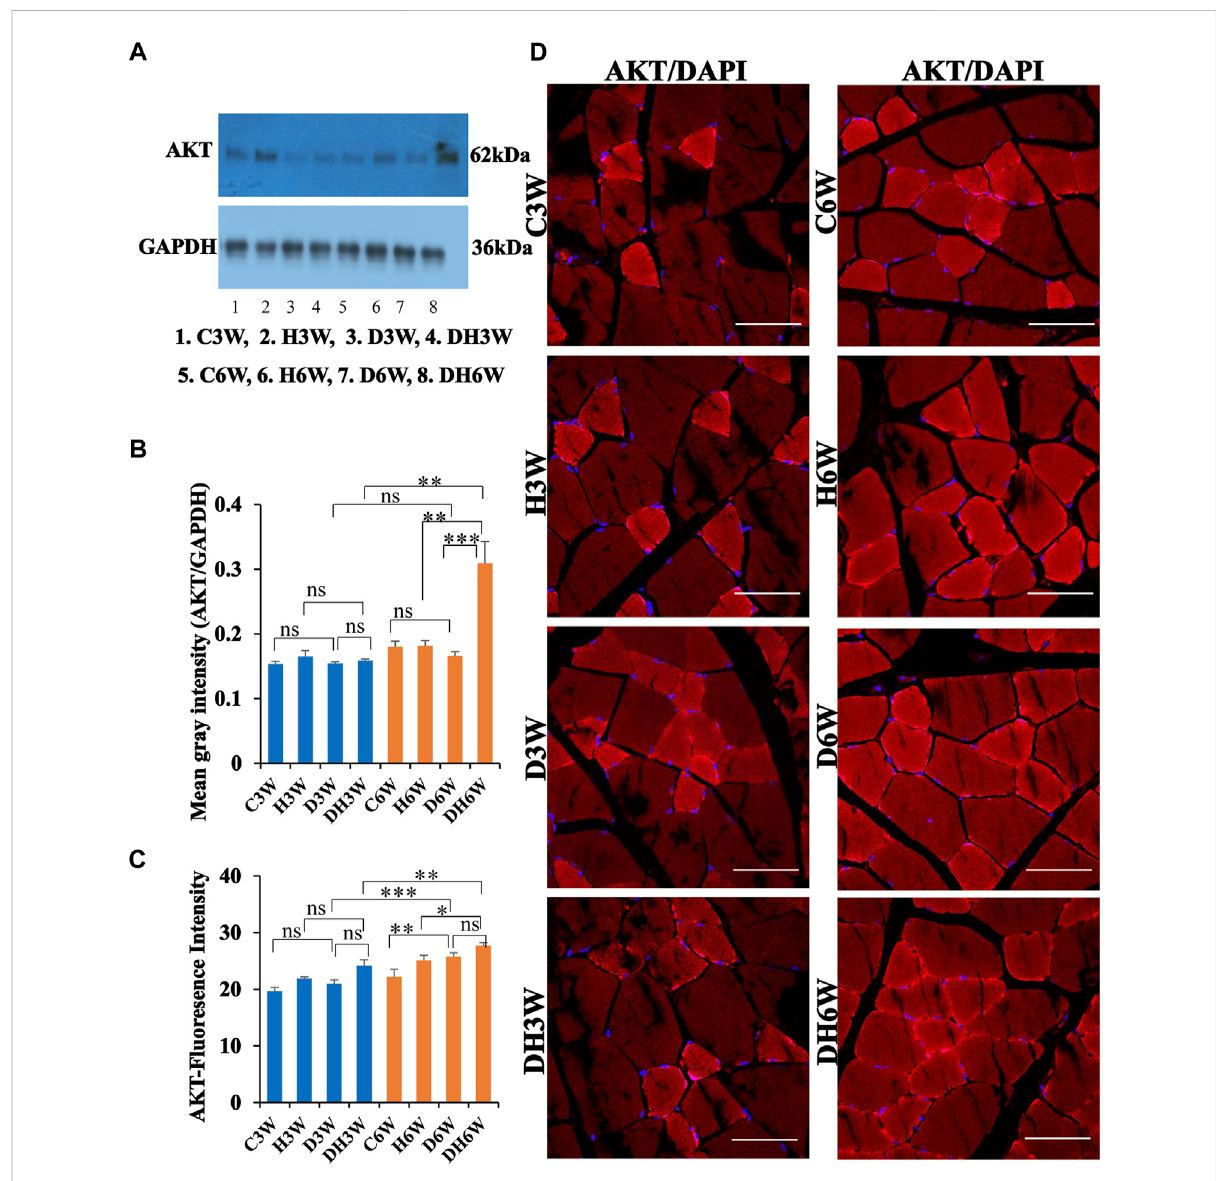
FIGURE 10 (A,B) Immunoblots probed with anti-AKT antibody (A) and mean gray intensity of immunoblots. There were no signi fi cant differences in the expression of AKT (mean gray intensity) between groups in short-term experiment. However, it was increased signi fi cantly in DH6W compared to H6Wand signi fi cantly higher thanD6W.Therewasasigni fi cantincrease inAKT expressionfromshort term(DH3W) to long term(DH6W). (C,D) -AKT immuno fl uorescence intensity (C) and representative cross-section of muscle fi bers stained for anti-AKT immuno fl uorescence in short-term (left panel) and long-term (right panel) experiments (D) . Immuno fl uorescence data showed signi fi cantly increased fl uorescence intensity of AKT in D6W and DH6W compared to C6W and H6W respectively. There was a signi fi cant increase in AKT immuno fl uorescence from short-term (D3W and DH3W) to long-term (D6W and DH6W). Note large number of muscle fi bers showing immuno fl uorescence in D3W, DH3W, D6W, and DH6W (*, p < 0.05; **, p < 0.01; ***, p < 0.001, One-way ANOVA, Bonferroni multiple comparison tests, n = 6 in all groups). Scale bar = 50